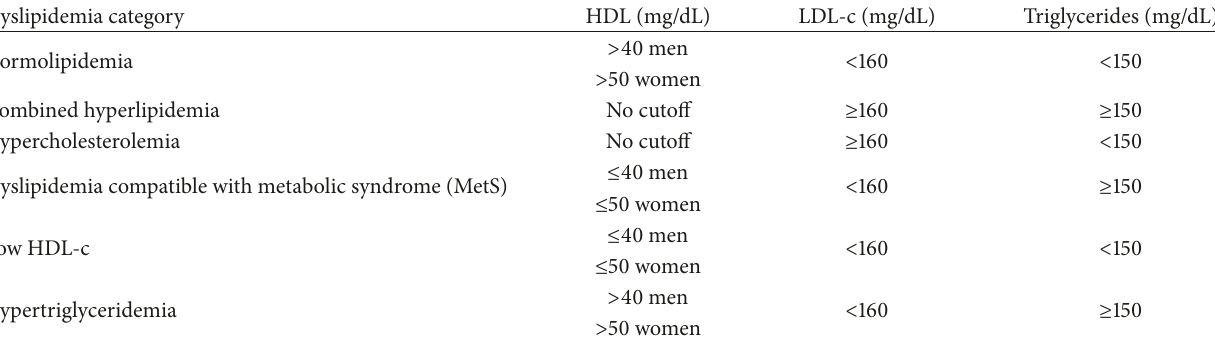
Table 1: Lipid categories defined by HDL, LDL, and triglyceride